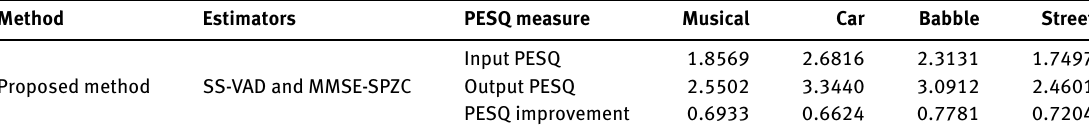
Table 10: Performance Measurement of Combined SS-VAD and MMSE-SPZC Estimator in Terms of PESQ for TIMIT Database. Method